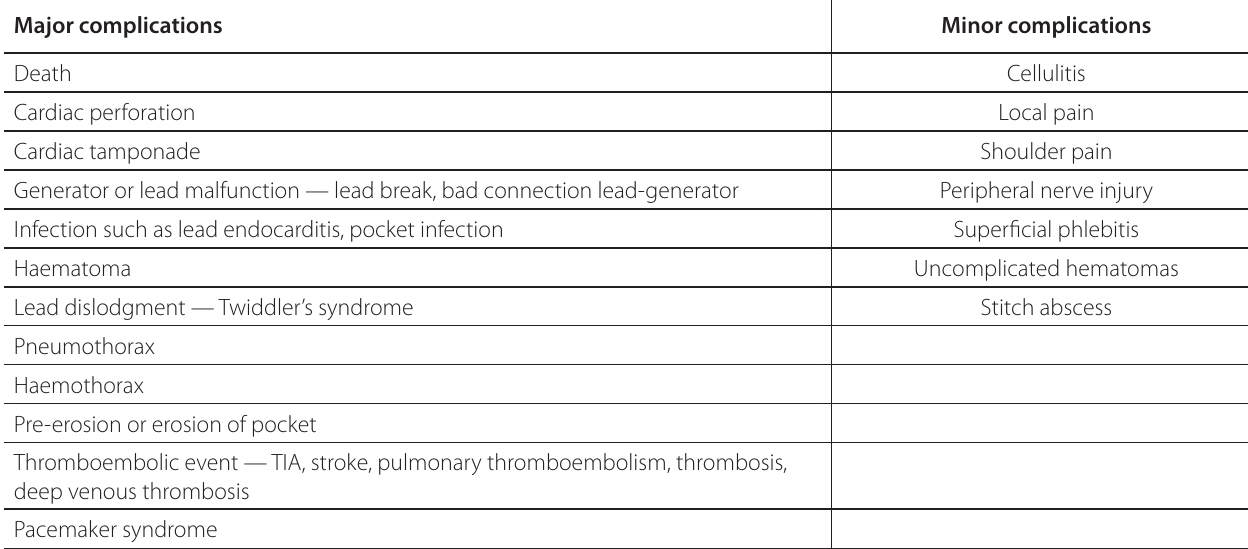
Table 7 . List of complications upon insertion of PPM post cardiac surgery [35-38] .